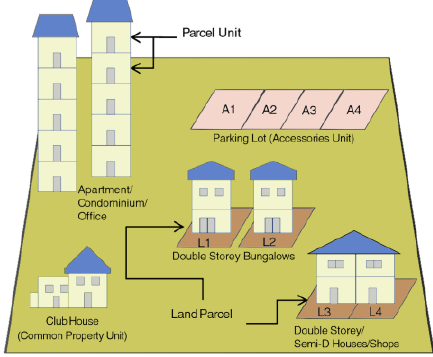
Figure 1. Strata related cadastral